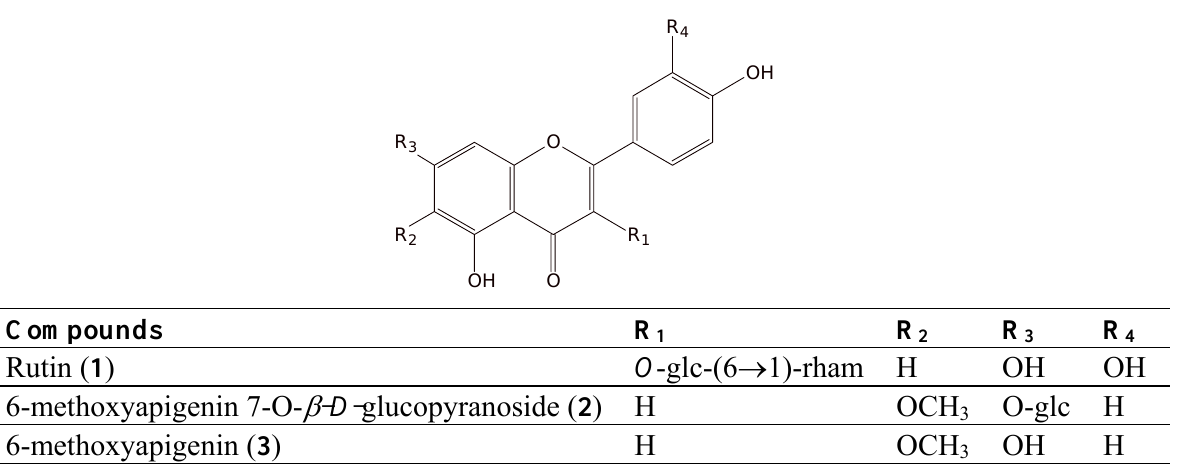
Figure 1. Chemical structure of the flavonoids.